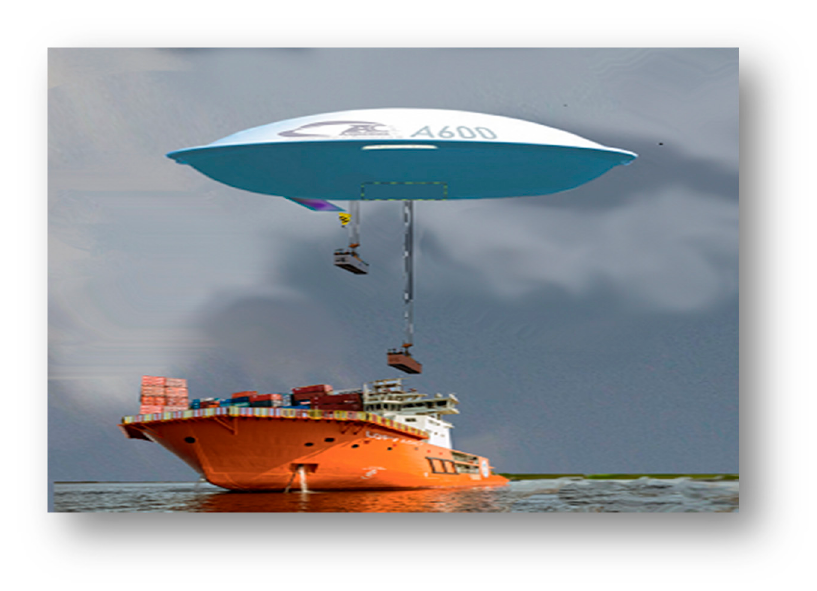
Figure 1. Prototype of a large capacity airship in handling.